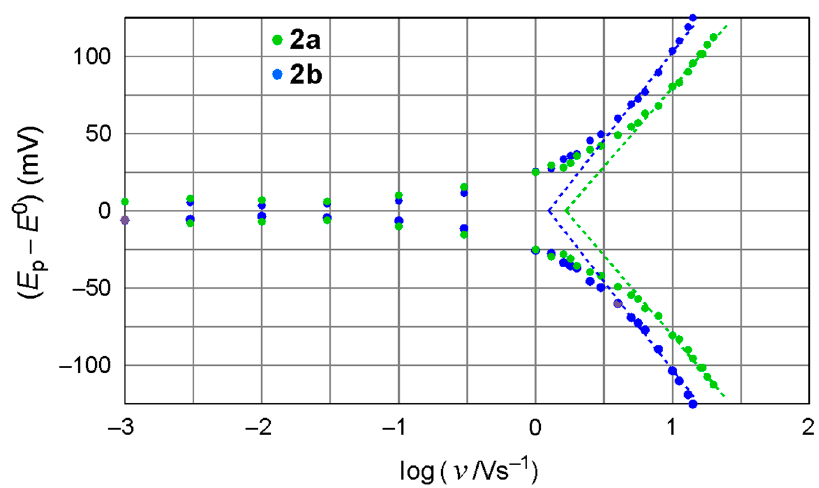
Figure 5. Plot of E p − E 0 versus the logarithm of scan rate for the SAMs of 2a and 2b on Au(111). E 0 was 0.371 and 0.392 V versus Ag/Ag + for 2a and 2b , respectively.